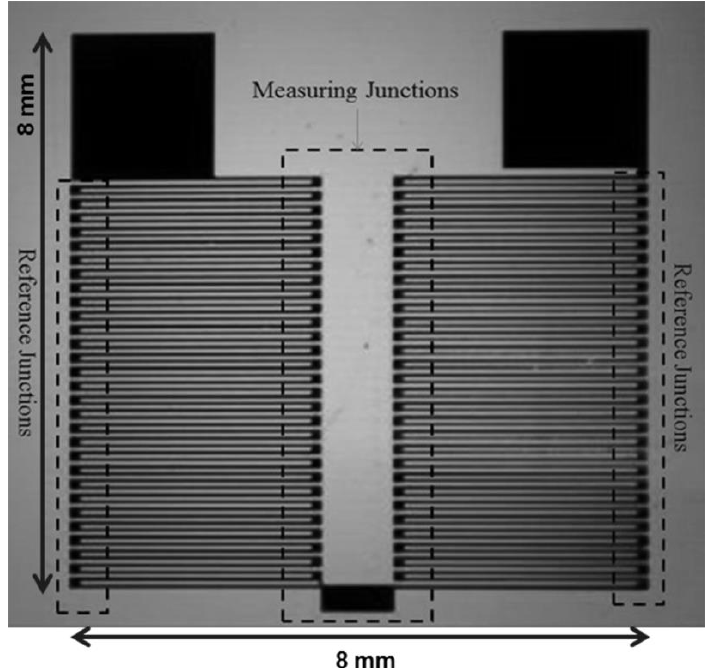
Figure 1. Thermopile (8 mm × 8 mm) fabricated on 100 µm kapton ® support showing measuring and reference